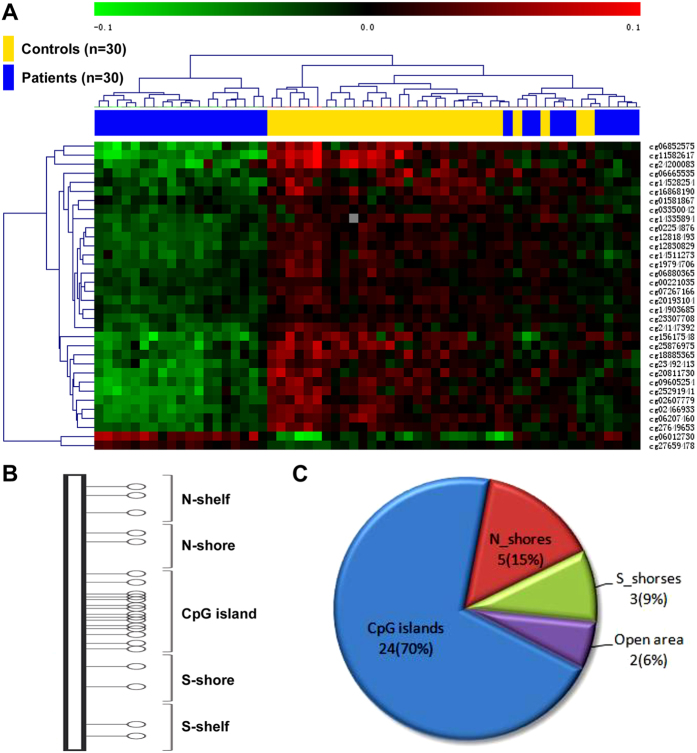
Analysis of differentially methylated DNA sites around the CpG island structures in mesial temporal lobe epilepsy.Panel (A) illustrates the heat map derived from clustering analysis of the microarray data from individual control (n = 30) and patient (n = 30) subjects as indicated above the heat map. Panel (B) shows the organization of the CpG island structures. Panel (C) plots the percentage distribution of the differentially methylated DNA sites at corresponding CpG island domains.